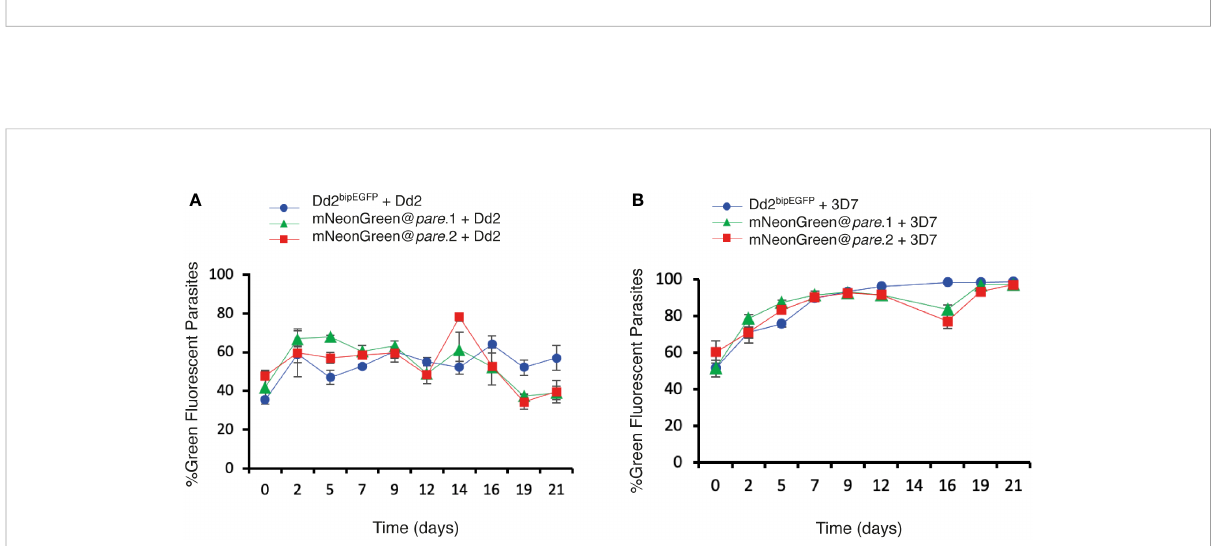
FIGURE 4 mNeonGreen@ pare lines demonstrate comparable fi tness to Dd2 bipEGFP when competed against Dd2 or 3D7. Fluorescent lines (mNeonGreen@ pare. 1, mNeonGreen@ pare. 2 and Dd2 bipEGFP ) were competed against (A) Dd2 or (B) 3D7 in triplicate biological replicates. The two populations were seeded at a 1:1 ratio at 1% parasitemia and maintained for 3 weeks. The parasitemia and fl uorescence were measured using fl ow cytometry every 2 nd or 3 rd day from day 0 to day 21. The percentage of green fl uorescent parasites over total parasites was averaged between the triplicates and graphed over time for each line. The error bars represent standard deviation between triplicates. The three fl uorescent lines did not outcompete Dd2 and remained close to the seeded percentages over three weeks. However, the fl uorescent lines quickly outcompeted 3D7.